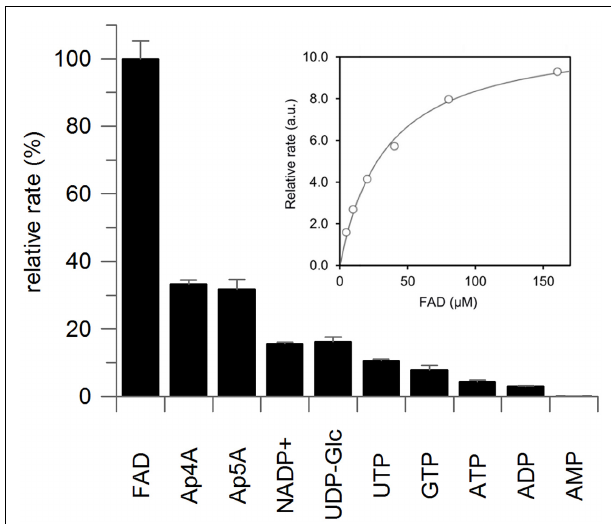
FIGURE 3 | Substrate specificity of recombinant maize nucleotide pyrophosphatase/phosphodiesterase. Substrates (0.5 mM) were incubated with the purified enzyme in 100 mM McIlvaine buffer containing 20 mM MgCl 2 at 37 ◦ C for the period of 30 min, during which both the decrease in substrate concentration and increase in the product concentration were monitored by UFLC and the tangent was used to calculate the reaction rate. Graph depicts average of three technical replicates with standard deviation. The insert shows the saturation curve of FAD hydrolysis with maximal velocity on y -axis expressed in arbitrary units (a.u.), from which K m of 32.7 ± 3.0 µ M was calculated by GraFit